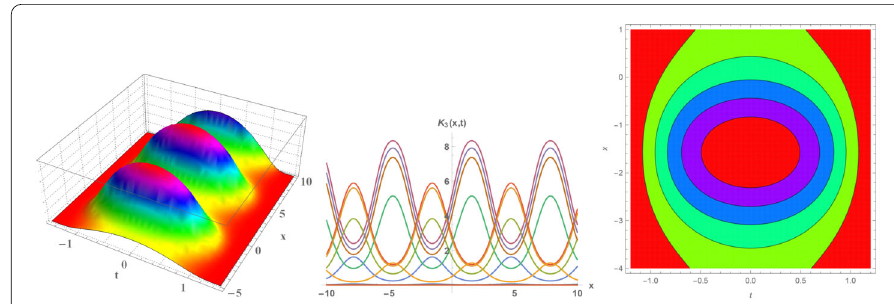
Figure 1 Numerical simulation of Eq. (13) in three distinct types of plots